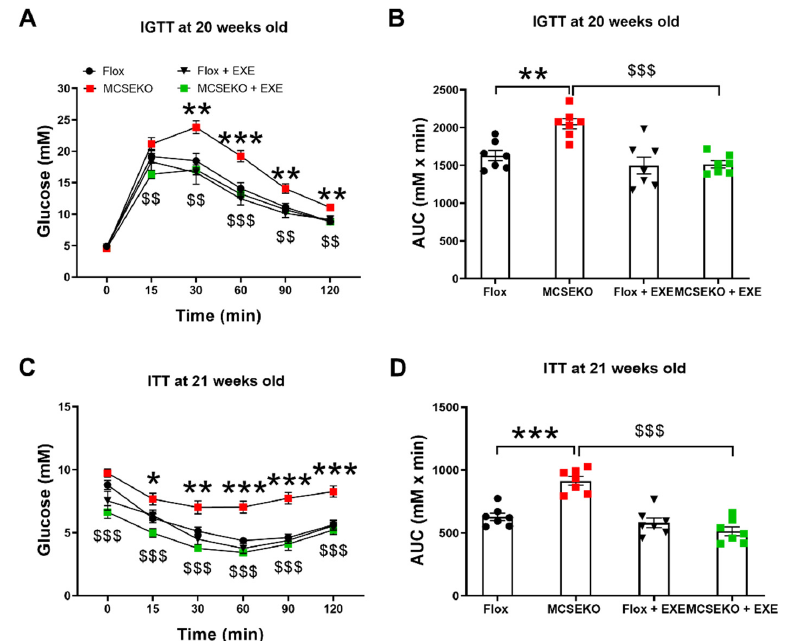
Figure 7. Aerobic treadmill exercise improves glucose tolerance and insulin sensitivity in MCSEKO mice. MCSEKO mice and Flox mice were housed under standard conditions. Aerobic treadmill exercise was performed on the mice at 14 weeks old for six weeks. ( A , B ) IGTT in Flox mice, the MCSEKO mice, Flox + EXE mice, and the MCSEKO + EXE mice at the age of 20 weeks ( n = 7 in each group). ( C , D ) ITT in Flox mice, the MCSEKO mice, Flox + EXE mice, and the MCSEKO + EXE mice at the age of 21 weeks ( n = 7 in each group). Data are expressed as means ± SEM. * p < 0.05,